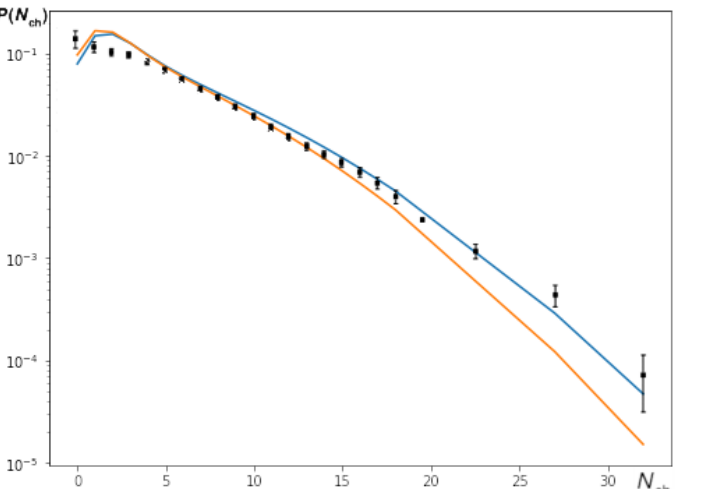
Figure 14. Multiplicity distribution in pp collisions at 2.36 TeV. Dots—experimental data [101], orange line—model predictions at k = 0.76, blue line—at k =